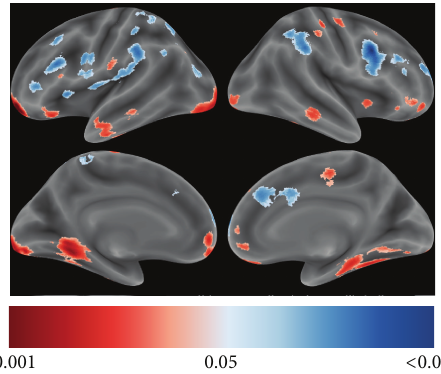
Figure 5: Whole-brain statistical maps VBM analyses. Statistical parametric maps (SPMs) illustrating increases (red) and decreases (blue) in GM volume following iTBS. Color bar values for all SPMs indicate uncorrected 𝑃 values ranging from 0.05 to